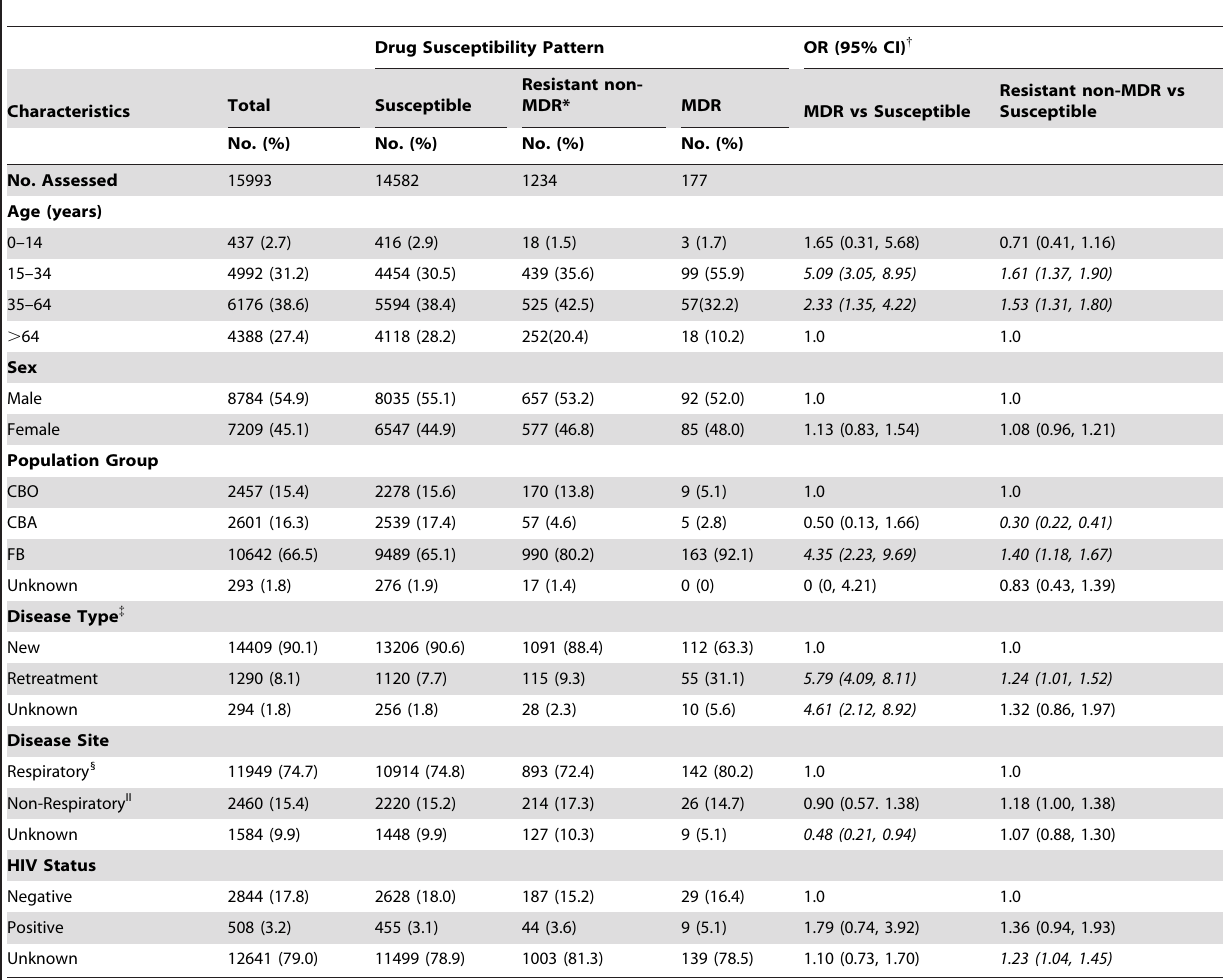
Table 1. Demographic features and disease characteristics of culture-positive tuberculosis cases in Canada by drug susceptibility pattern of incident case isolate